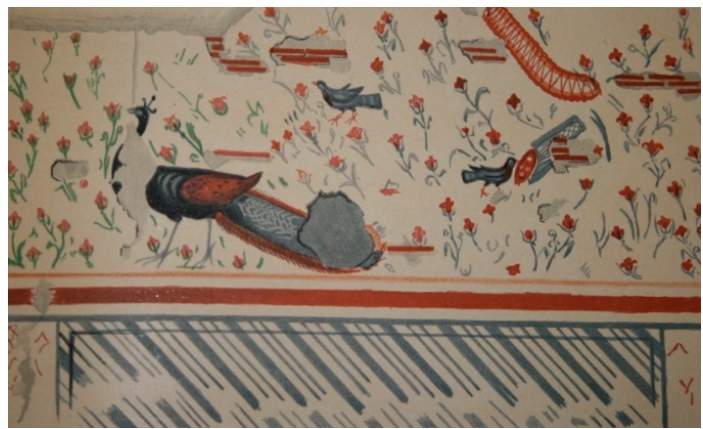
Figure 8. Sardis, “Painted Tomb” (Appendix A.2 T2), painting of west wall. © Archaeological Exploration of Sardis/President and fellows of Harvard College.